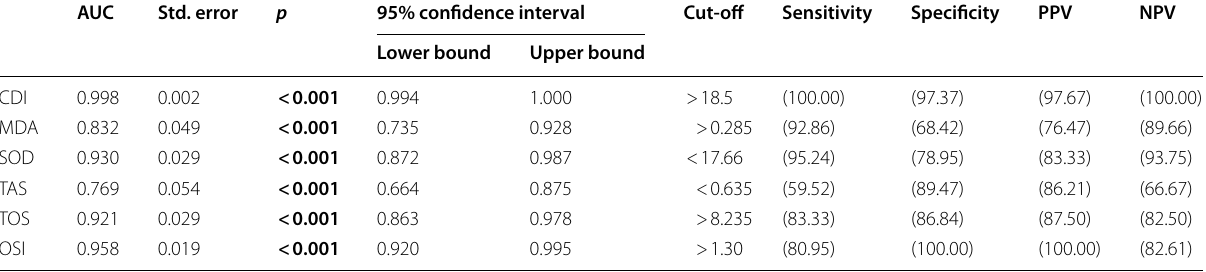
Bold indicates p -value ROC analysis